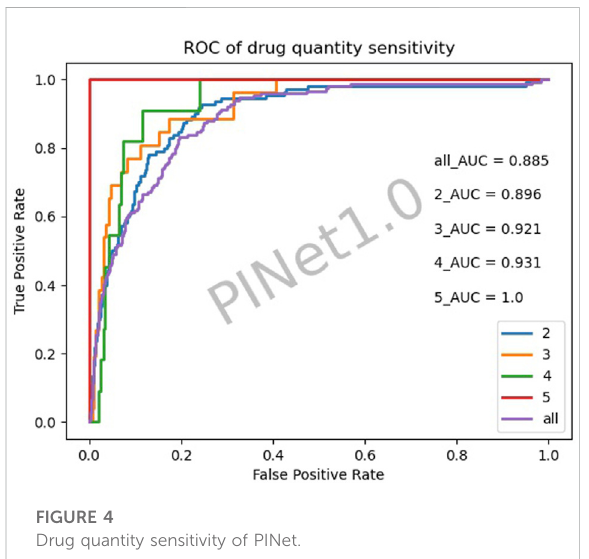
FIGURE 4 Drug quantity sensitivity of